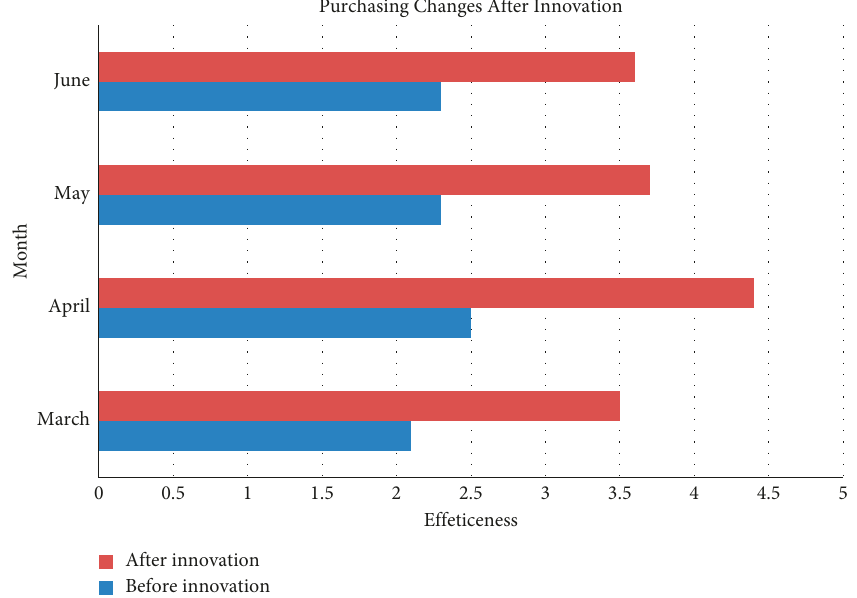
Figure 1: Analysis of nanomaterials logistics innovation experiment.